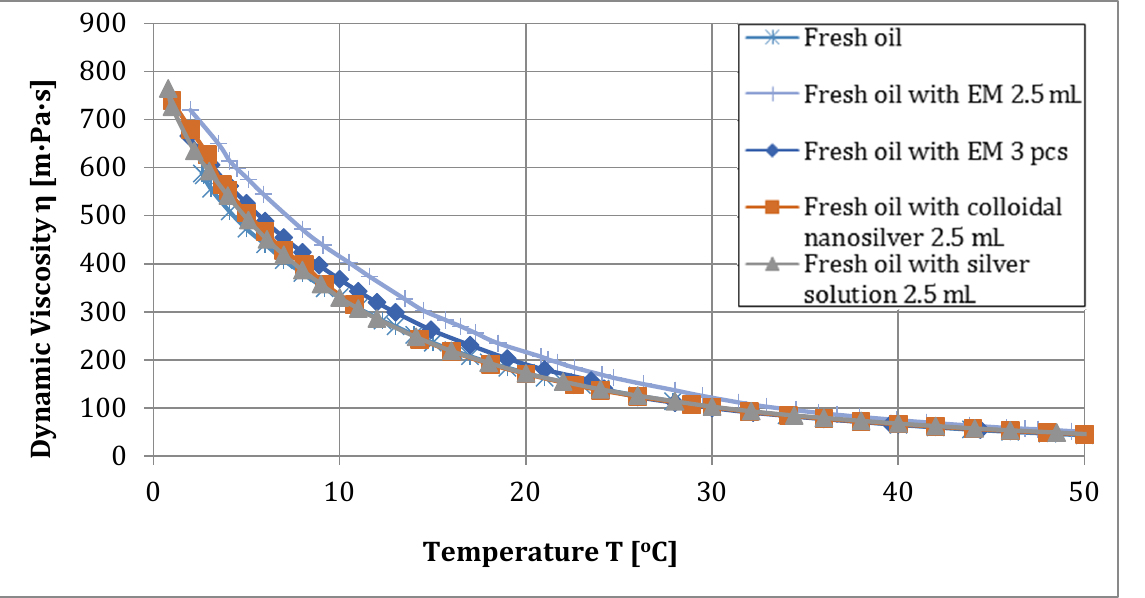
Figure 8. Viscosity for oil samples with the addition of effective microorganisms (EM), colloidal nanosilver (CN), and silver solution (SS).